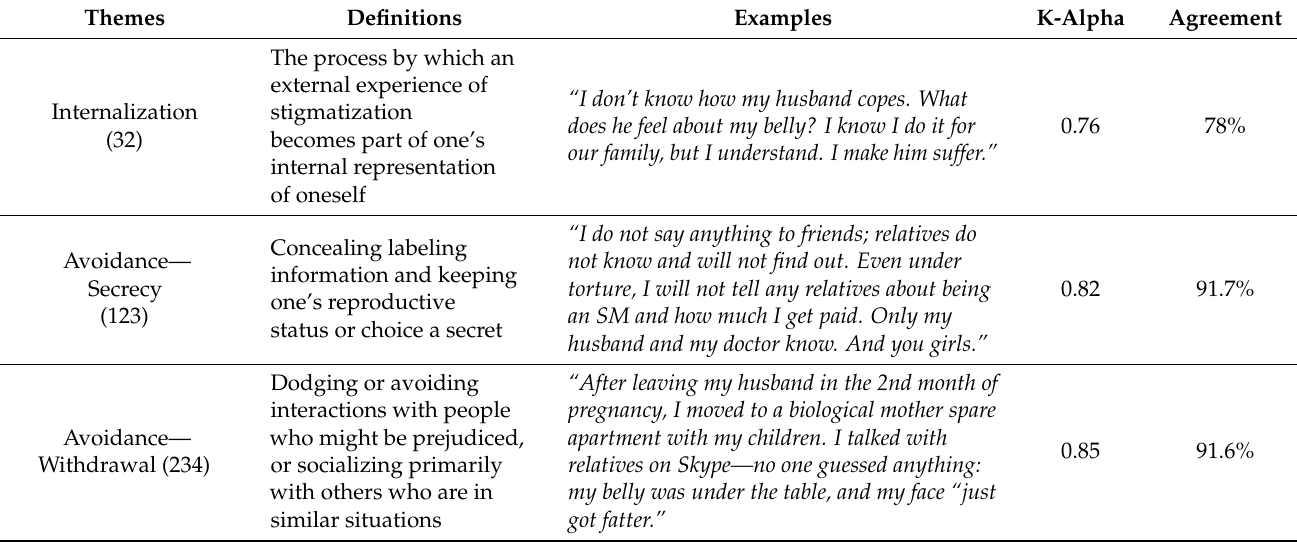
Table 1. Overview of coding, definitions, and